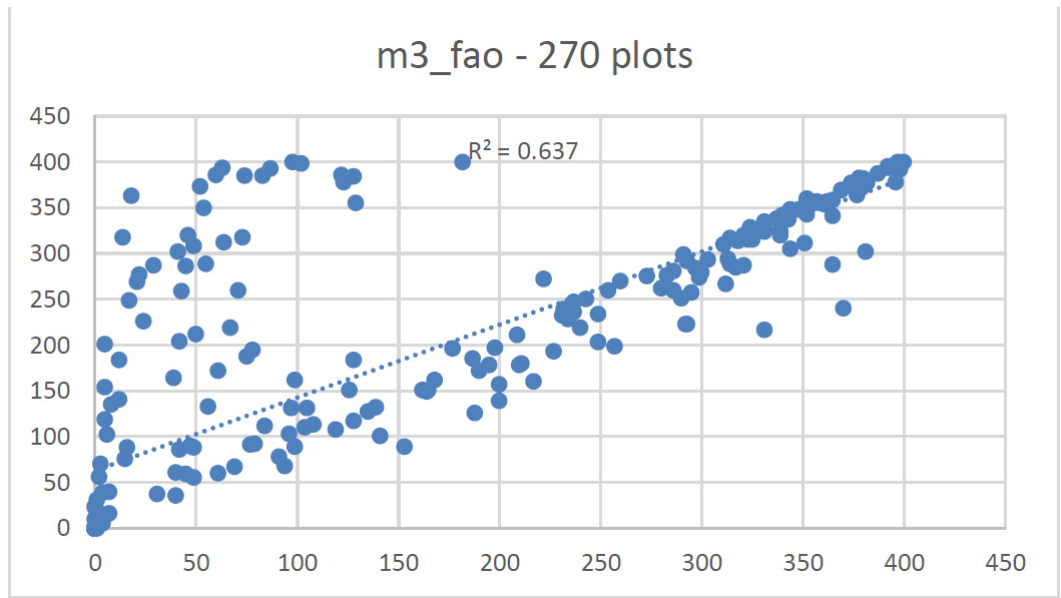
Figure A9. Reference area compared to estimated forest area by Method 3 for test plots (10 × 10 m 2 ) according to FAO/UN definition.